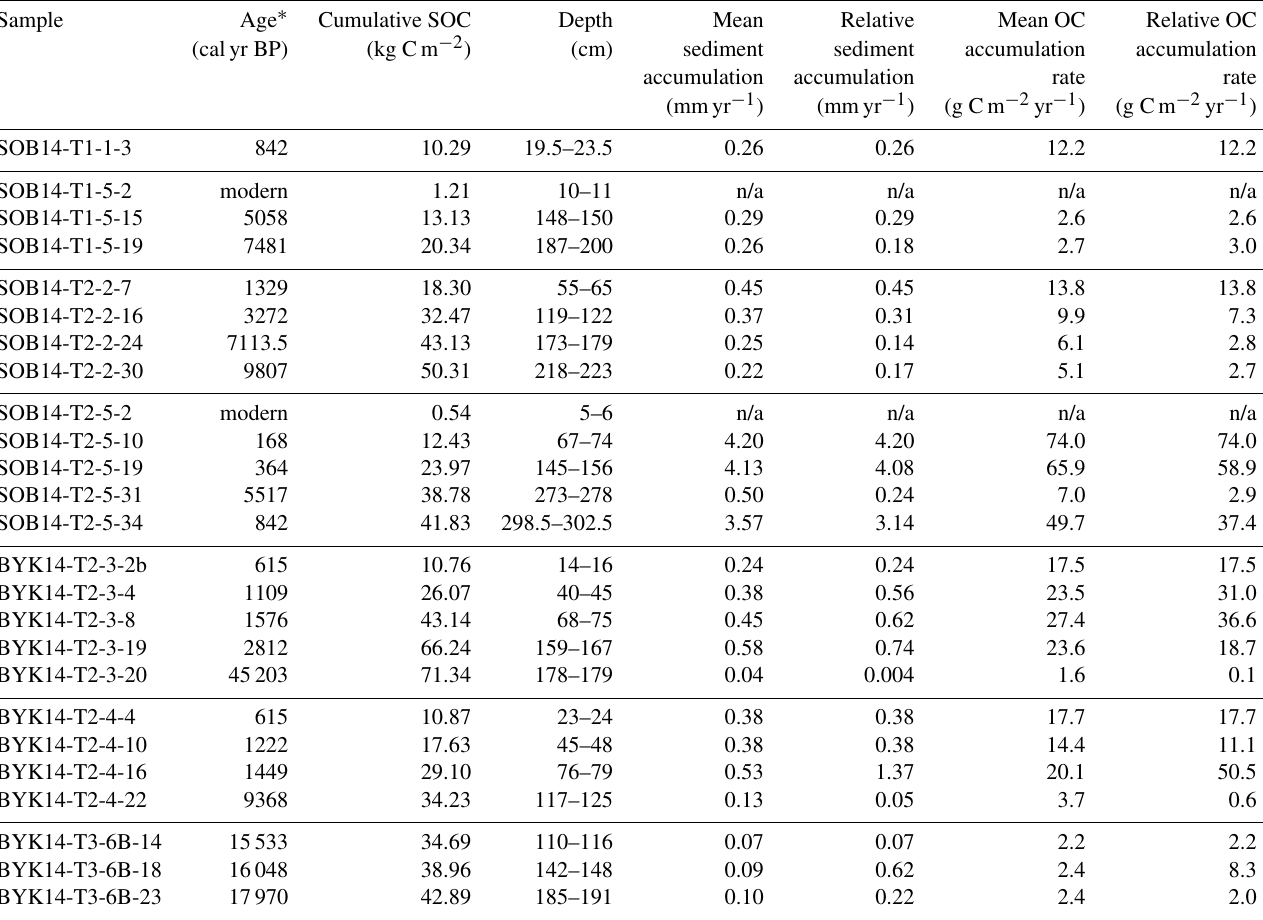
Table 4. Sediment and organic carbon accumulation rates (OC accumulation rate). Sediment accumulation rates are based on the depth of the sample and the calibrated radiocarbon date. Organic carbon accumulation rates are based on cumulative soil organic carbon (cumulative SOC) storage at a specific depth and the calibrated radiocarbon date at the corresponding depth. Mean sediment and organic carbon accumulation rates are calculated, always referring to the soil surface (depth = 0cm and cumulative SOC = 0kg Cm − 2 ) . Relative sediment and organic carbon accumulation rates are calculated always referring to the sample above a particular